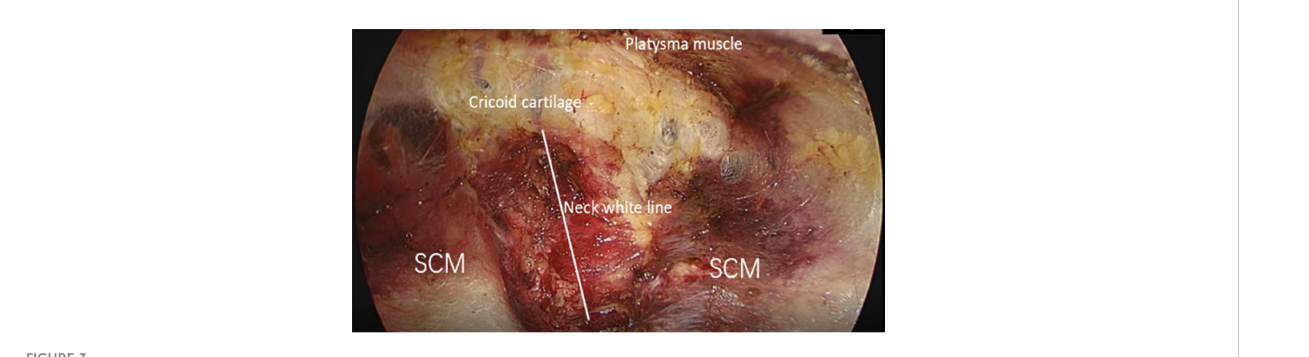
FIGURE 3 Operation space establishment and the structure of dissection under